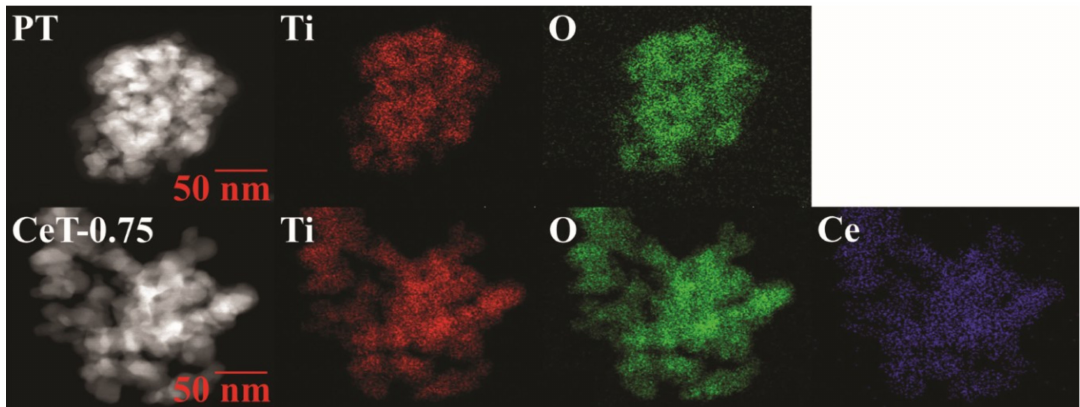
Figure 6. Elemental mapping images of pure TiO 2 (PT) and Ce-doped TiO 2 (CeT-0.75) nanostructures. The average particle sizes of P25, PT, and CeT-0.75 were 24.6 nm, 22.5 nm, and 13.2 nm, respectively, and the other CeT photocatalysts with Ce contents were in the particle size range of 13.6 to 15.3 nm particles to have the same spherical shape and size [46].